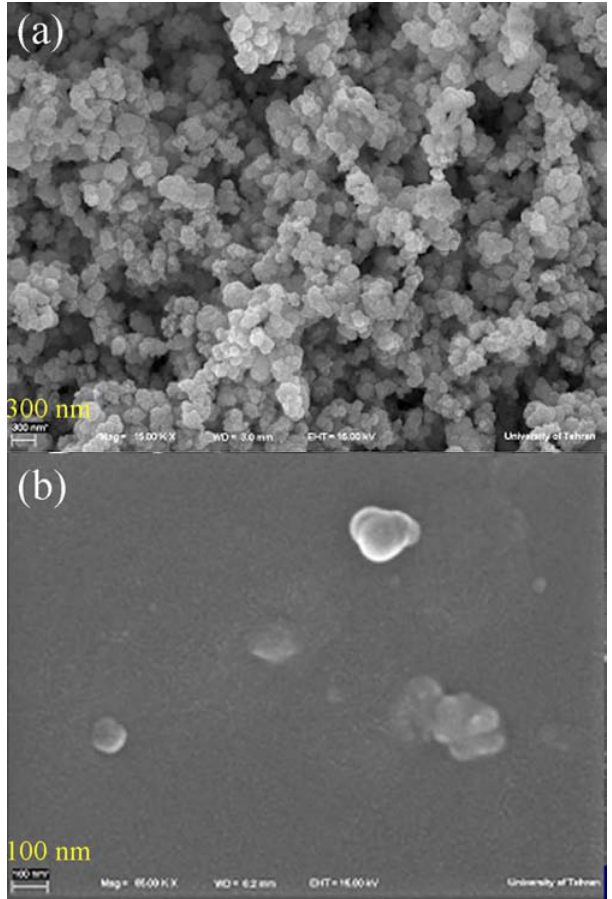
Fig. 5. SEM image of (a) CuFe starch/CuFe